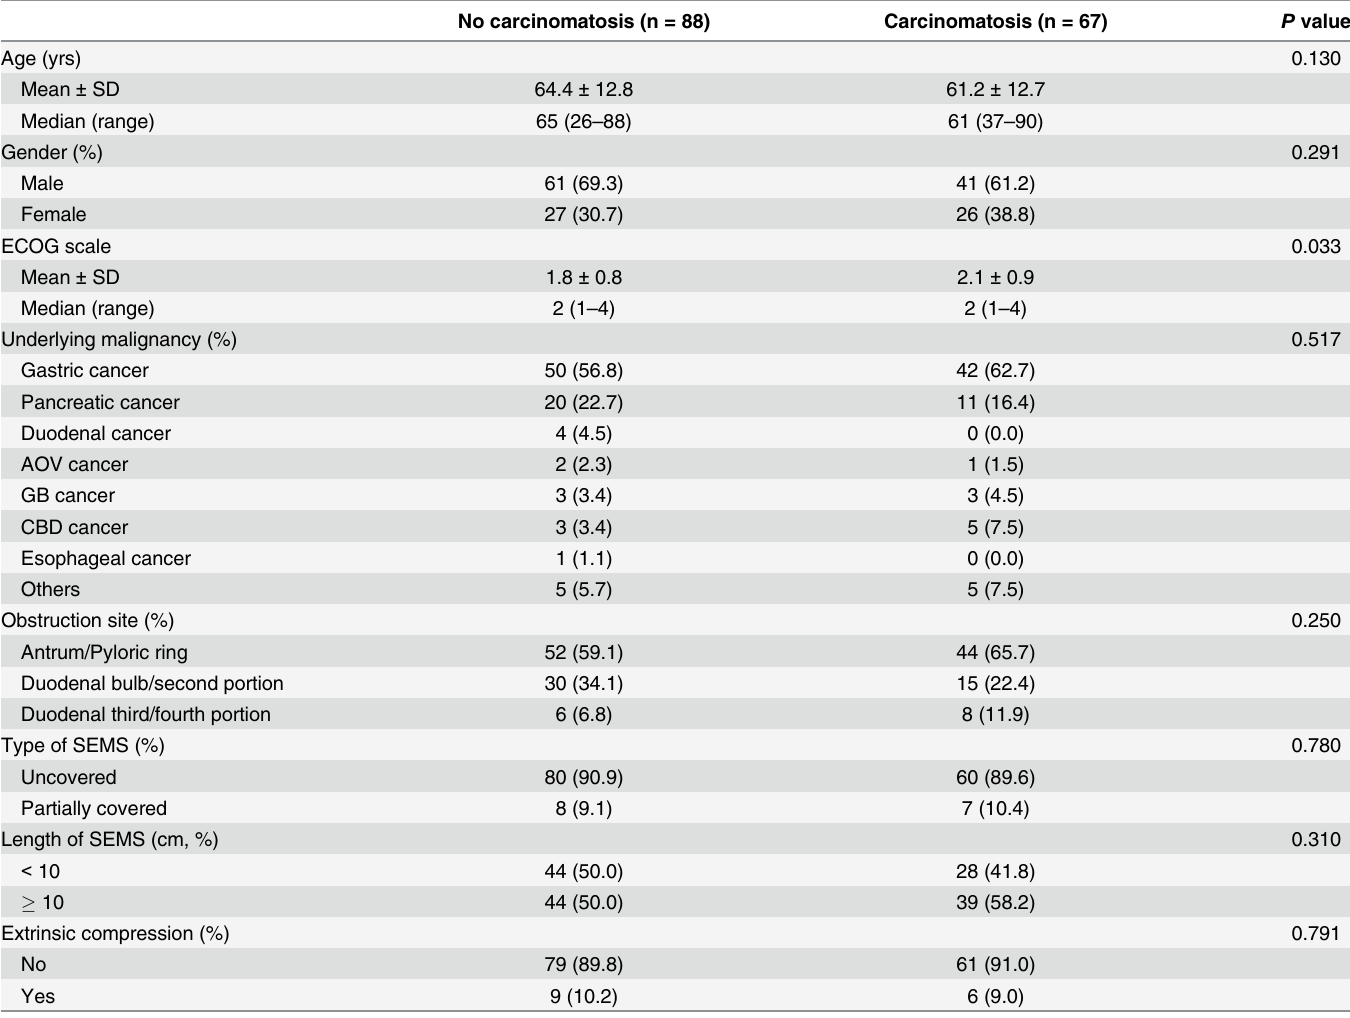
Table 1. Comparison of baseline characteristics according to the presence of